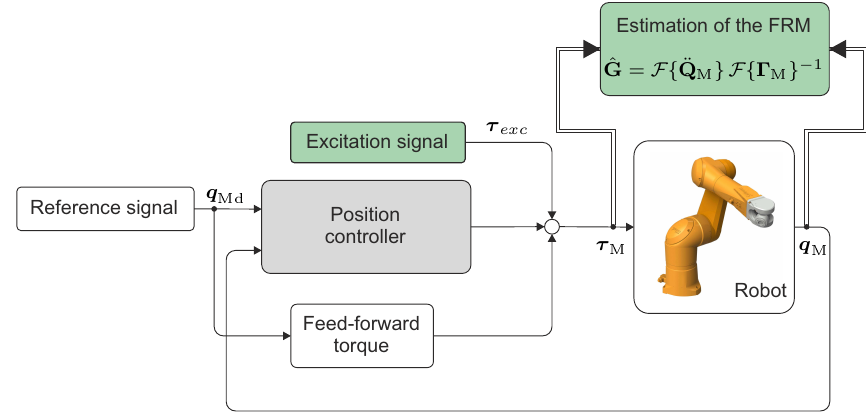
Figure 3. Block diagram of the control